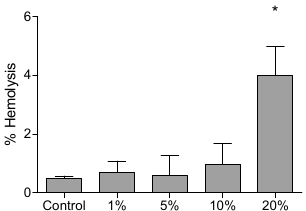
Figure 1. Hemolytic effect of different dimethyl sulfoxide (DMSO) concentrations (1, 5, 10, and 20% v/v ). Hemolysis percentage after 4 h of incubation ( n = 6 subjects). Results were expressed as mean and standard deviation (SD). * Statistically significant difference when compared to the control culture ( p < 0.05, one-way ANOVA followed by Tukey’s post hoc test).